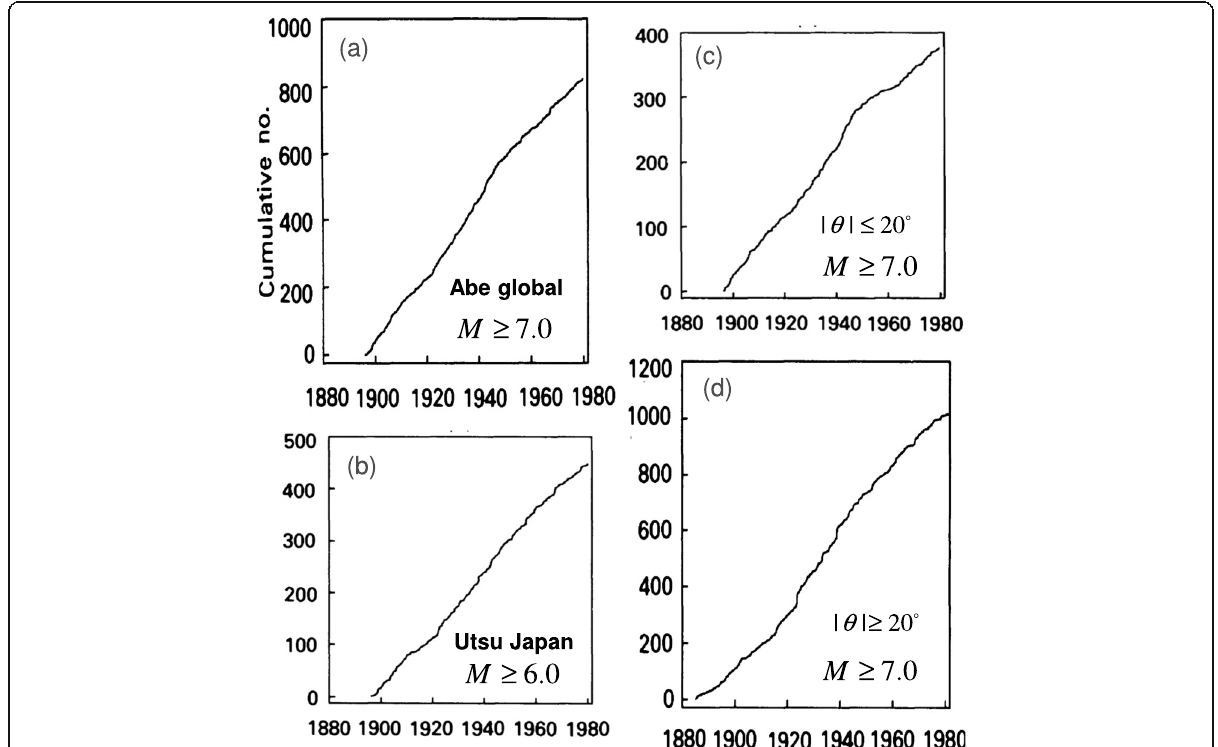
Fig. 5 Cumulative number of shallow earthquakes. Panels are a with M S ≥ 7 globally, b with M JMA ≥ 6 in the regional area around Japan (1885 – 1980) based on Utsu ’ s catalog, c with M s ≥ 7 in low latitude areas, | θ | ≤ 20 o , of the world (1897 – 1980), and d M s ≥ 7 in high latitude areas, | θ | > 20 o , of the world (1897 – 1980), where θ is the